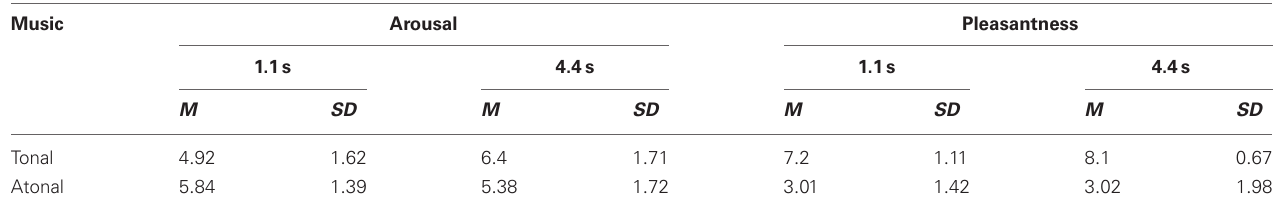
Table 5 | Mean and standard deviation of ratings of arousal and pleasantness (on a 9-point scale) for musical excerpts in tonal and atonal conditions for a 1.1 and a 4.4-s